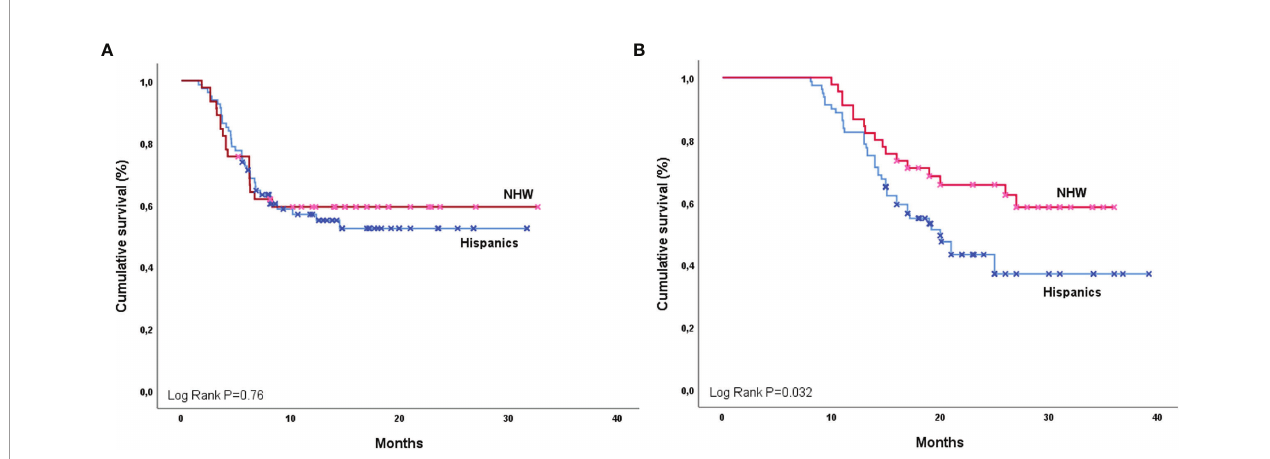
FIGURE 1 | Progression-free survival (A) and overall survival (B) by ethnicity (Hispanic and